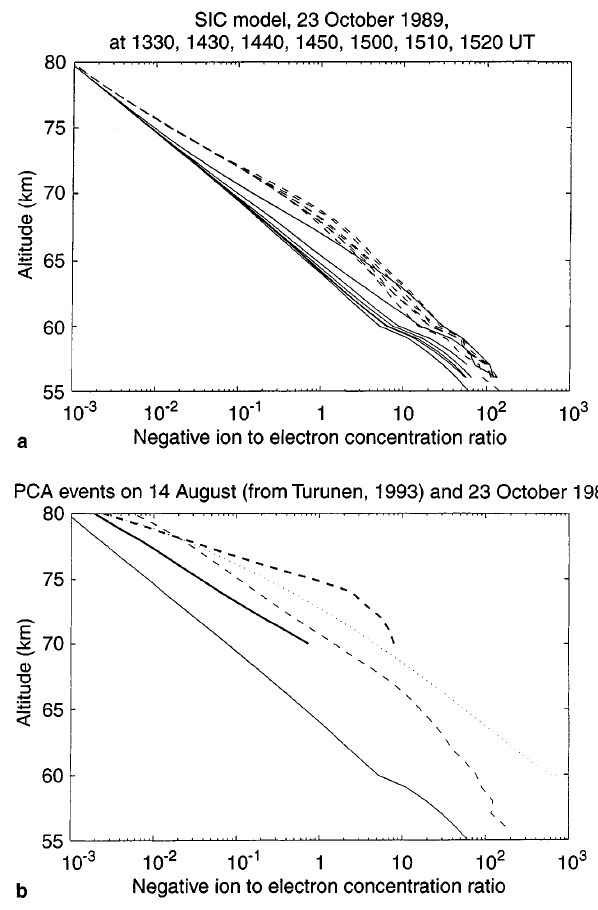
Fig. 7. a Height profiles of the total negative-ion ratio, k (cid:255) , corresponding to Fig. 3. To stress the importance of photodetach- ment we display together the results from the full model calculations ( solid lines ), and the results without photodetachment and photodis- sociation ( dashed lines ). For practical reasons the lines are not numbered, the zenith angle increases in the curves from left to right . b Total negative-ion ratio for 23 October, 1989, at 1330 UT ( thin solid line ) and 1520 UT ( thin dashed line ), together with results for 14 August, 1989 (Turunen, 1993) at 0255 UT ( thick solid line ) and 0005 UT ( thick dashed line ). Note that the PCA event in August was weaker than in October. Also shown for comparison is the result without ionisation by protons, for 23 October at 1520 UT ( dotted line